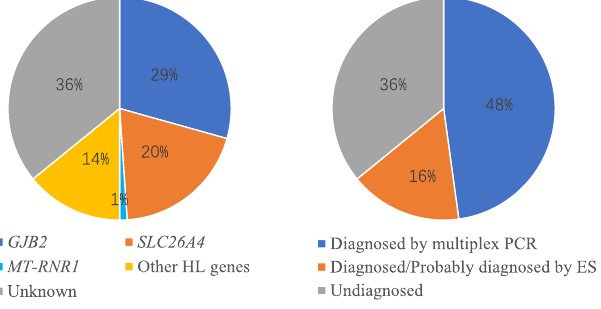
Figure 2. Genetic spectrum of enrolled non-syndromic hearing loss probands. Molecular diagnostic results were classified according to genes and detection methods. ES exome